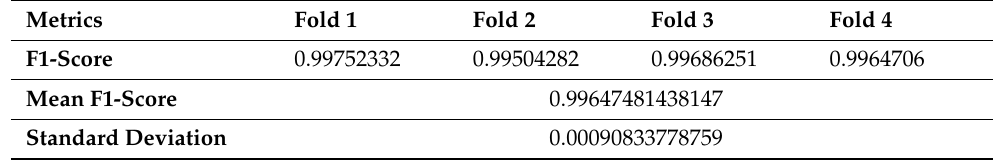
Table 7. EfficientNetB0 model: F1-scores per fold.